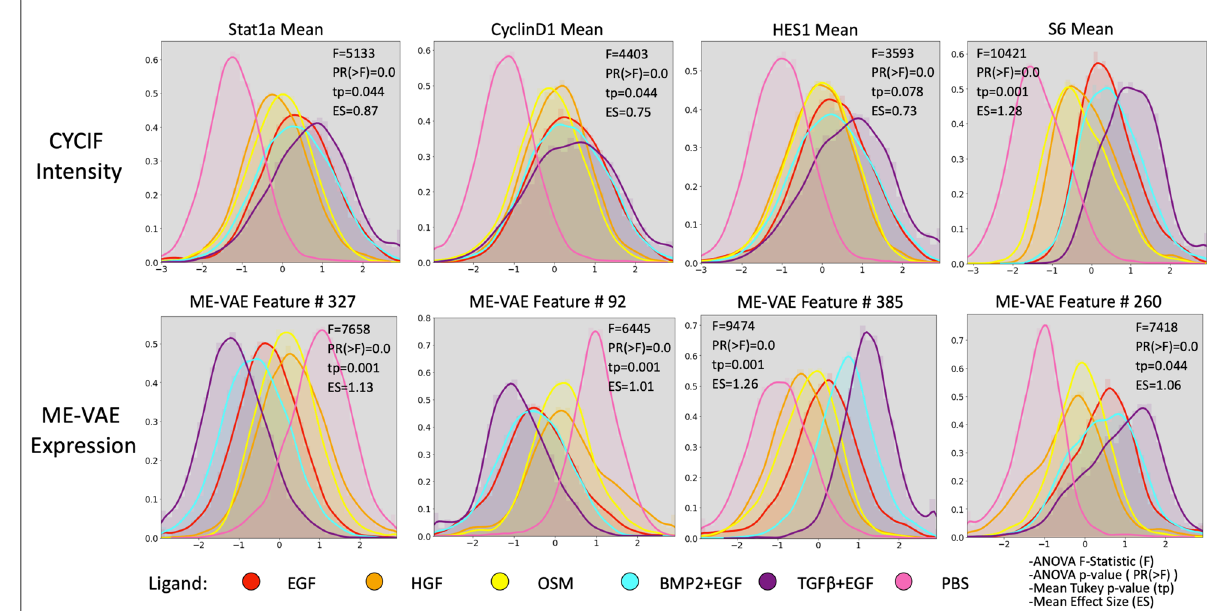
Fig. 5 Separability of ligands using individual ME-VAE features. Density function for several CYCIF and ME-VAE feature pairs. A two-sided ANOVA was performed for features and intensities between populations in order to compute the F statistic and p value (PR(> F )). Subsequently, the mean Tukey pairwise p value across ligands and mean effect size are shown for each feature. ME-VAE features used for comparison were the features with the largest correlation to the respective CYCIF marker. This analysis utilized all 73,134 cell images from the MCF10A